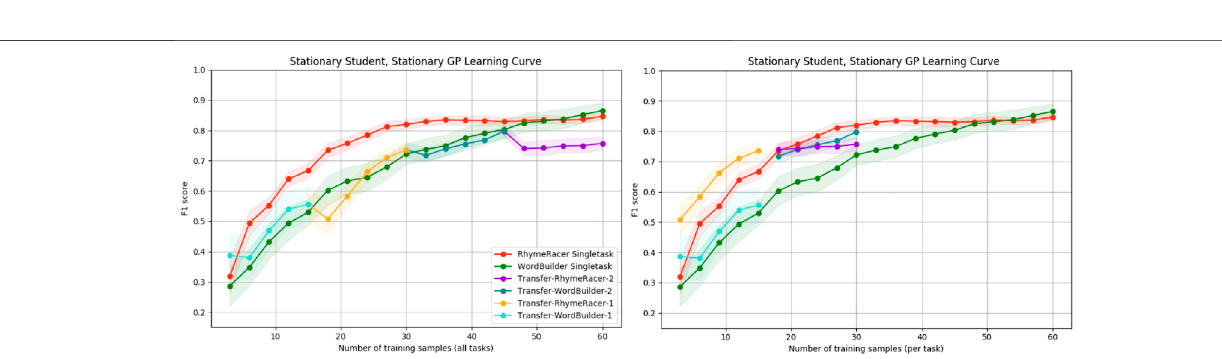
FIGURE6| Simple “ Pro fi ciency ” and “ Ef fi ciency ” evaluationofmulti-taskvs.single-taskpersonalizedmodelswhenRhymeRaceristhe fi rsttask.Thetransfermodel trades off fi nal classi fi er accuracy for multi-task generality and meets or exceeds single-task model performance with equal amounts of target task data.